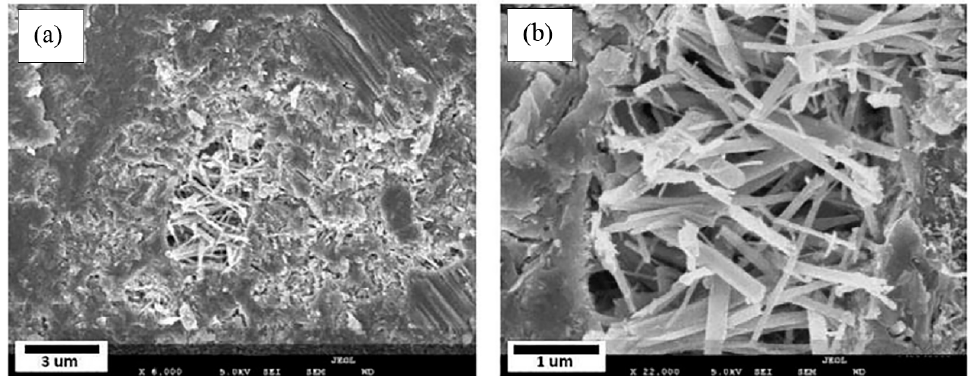
Figure 5. Effect of CNT incorporation on cement morphology (a) magnification 3 nanometer (b) 1 nanometer [113]. ( b ) 1 nanometer